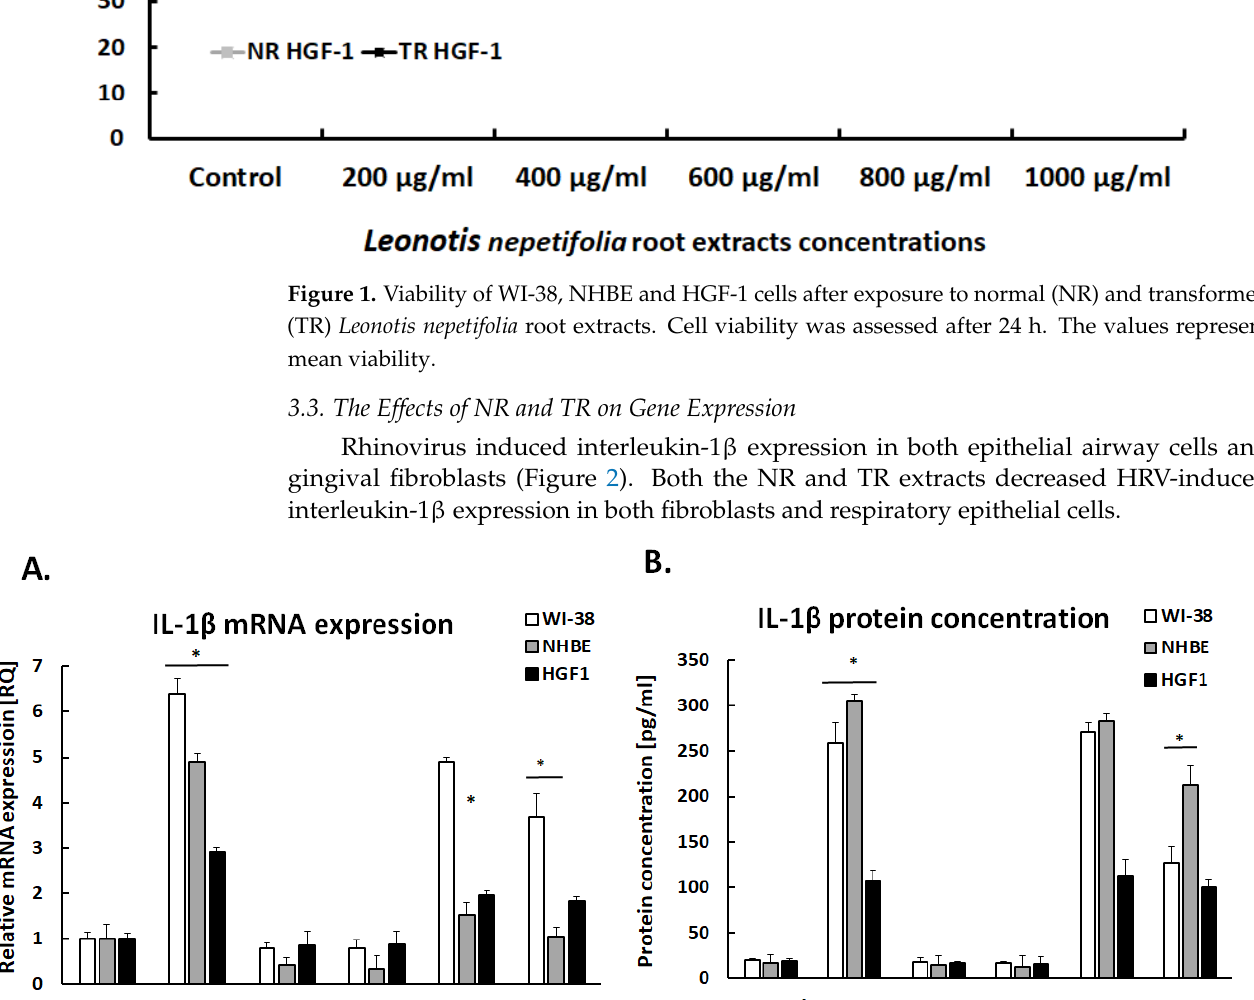
Figure 3. Leonotis nepetifolia extracts from normal (NR) and transformed (TR) roots, decreased vi- rus-induced IL-6 expression on mRNA ( A ) and protein ( B ) levels. Data presented as mean ± SEM, * p < 0.05. Interestingly, none of the tested extracts had any significant effect on GM-CSF ex- pression in lung fibroblasts or gingival cells (Figure 4). The TR extract reduced GM-CSF expression in bronchial epithelial cells, but not HRV-induced expression. The tested ex- tracts had no effect on MCAF expression ( p > 0.05, Figure 5).